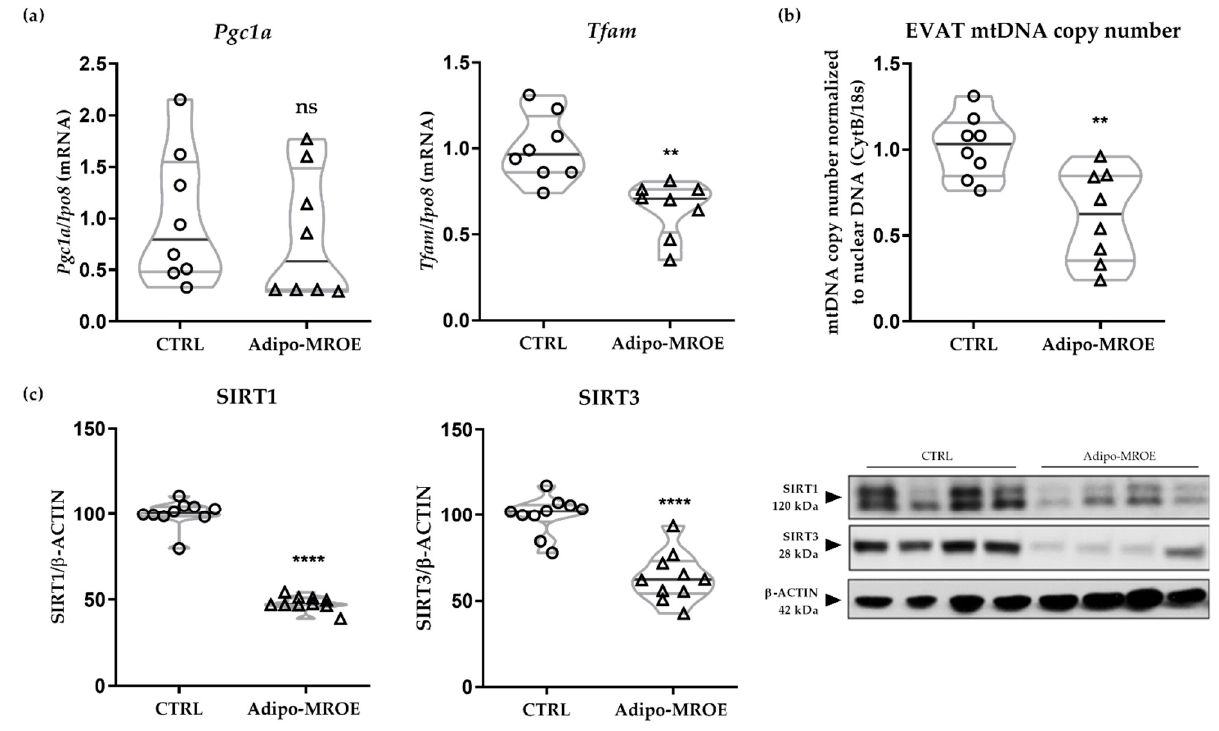
Figure 4. Mitochondrial biogenesis is impaired in the EVAT of adipocyte-MR overexpressing mice. ( a ) mRNA Pgc1 α levels, as measured by qRT-PCR, are unchanged in the EVAT of Adipo-MROE mice, whereas Tfam levels are decreased; ( b ) Consequently, average mtDNA copy number per cell normalised over nuclear DNA copy number is decreased in the EVAT of Adipo-MROE mice. ( c ) Protein levels of SIRT1 and SIRT3 are decreased in the EVAT of Adipo-MROE mice; data are expressed as violin plots with quartiles and individual dots. n = 8–10 mice per group; ** p < 0.01; **** p < 0.0001; ns = not significant, Adipo-MROE vs. control. CytB : cytochrome B; EVAT: epididymal visceral adipose tissue; Ipo8 : importin 8;